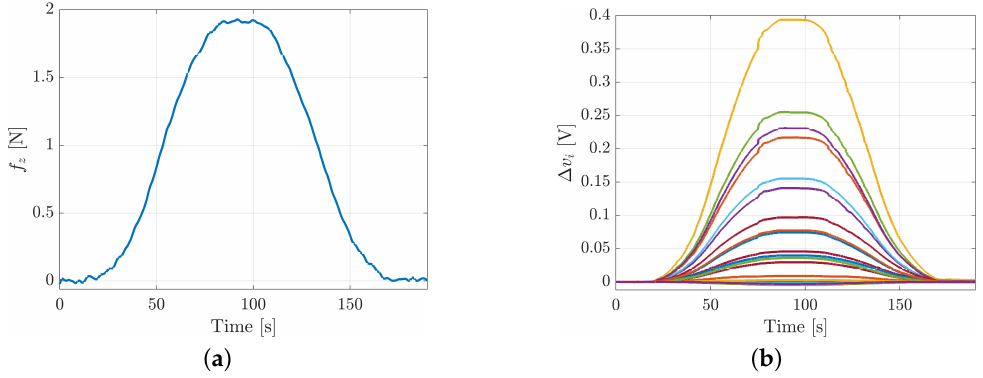
Figure 8. Hysteresis experiment for taxel 17: applied force ( a ) and voltage variations ( b ). The hysteresis graph has been obtained by plotting the force values on the x -axis and the voltage values on the y -axis. The hysteresis error has been computed by finding, for each taxel, the maximum difference between the voltage variation values on the two hysteresis branches, corresponding to the same force value, by using the following equation: